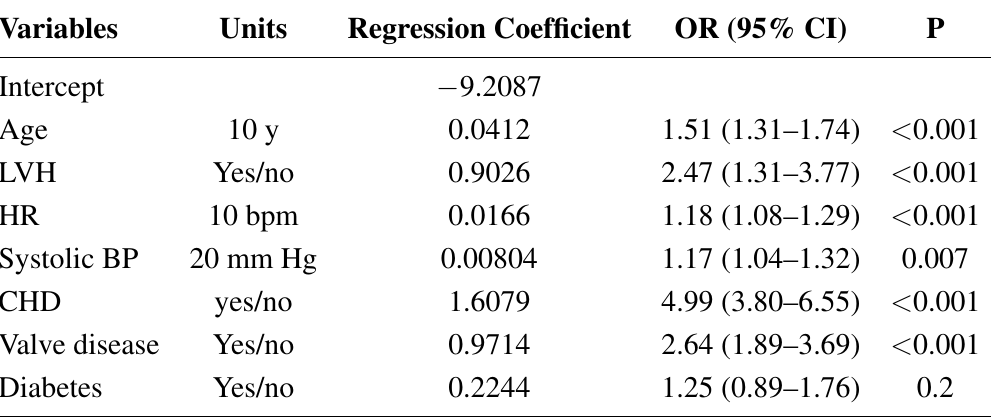
Table 4. Pooled logistic regression model for men with coefficients (the model is without vital capacity and chest X-ray information). OR, odds ratio; CI, confidence interval; LVH, left ventricular hypertrophy; CHD, congenital heart